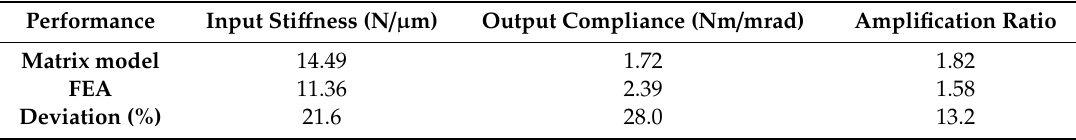
Table 2. Performances evaluated by the analysis model and finite element analysis (FEA) results.